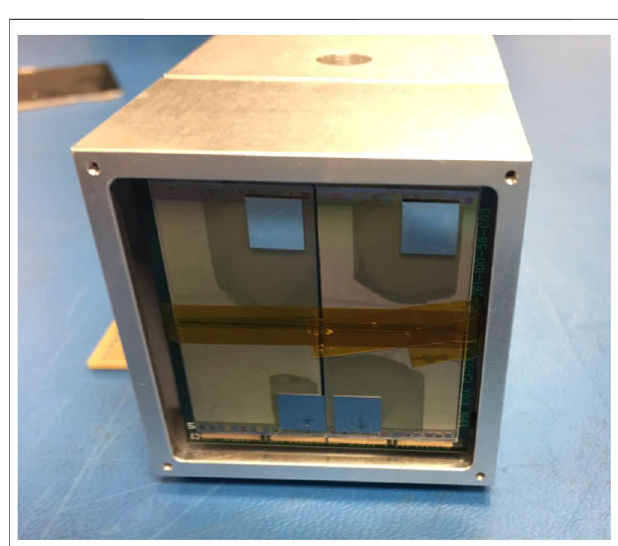
FIGURE 5 | Camera assembled with prototype shallow entrance window sensors bump-bonded to SLAC ePix100 read-out ASIC.